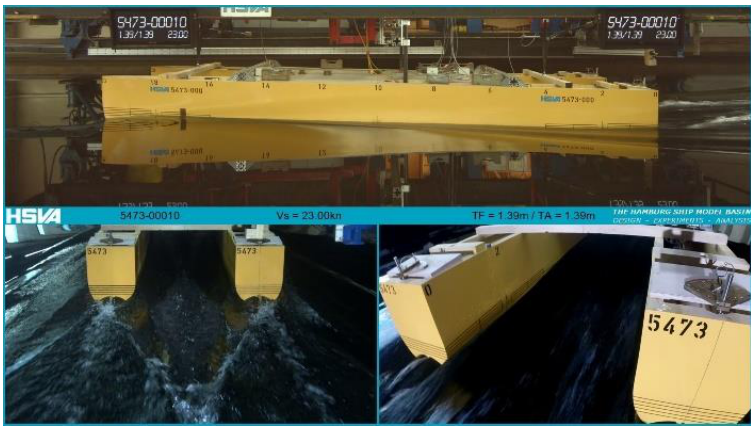
Figure 16. Self-propulsion model of the Stavanger demonstrator at 23 knots full scale speed.